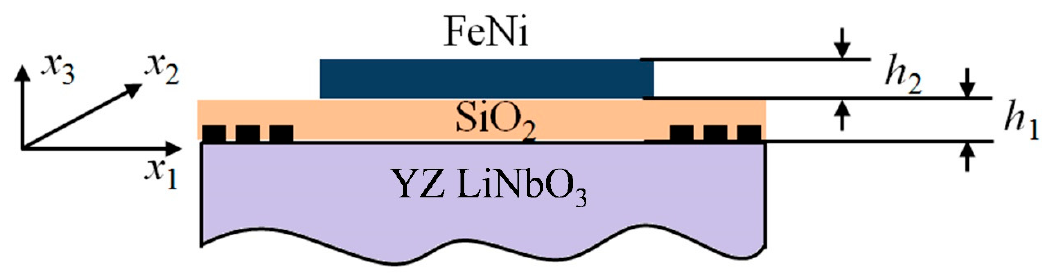
Figure 2. The corresponding coordinate system in this work.